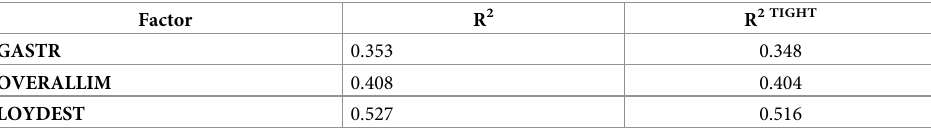
Table 7. Predictive relevance of the